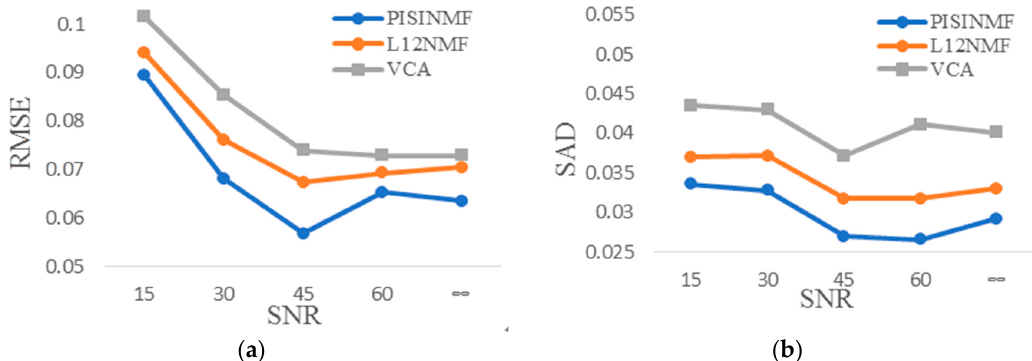
Figure 10. Experimental results with different SNR ( a ) RMSE; ( b ) SAD. Table 3. SAD comparison with different SNR